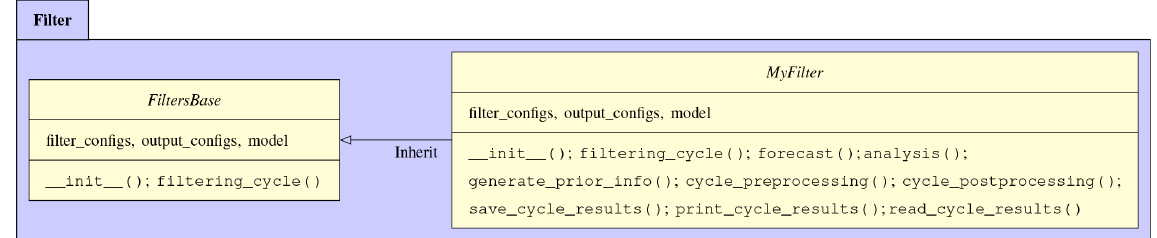
Figure 19. Illustration of a DA filtering class MyFilter and its relation to the filtering base class. A solid arrow represents an “inherit” relation.